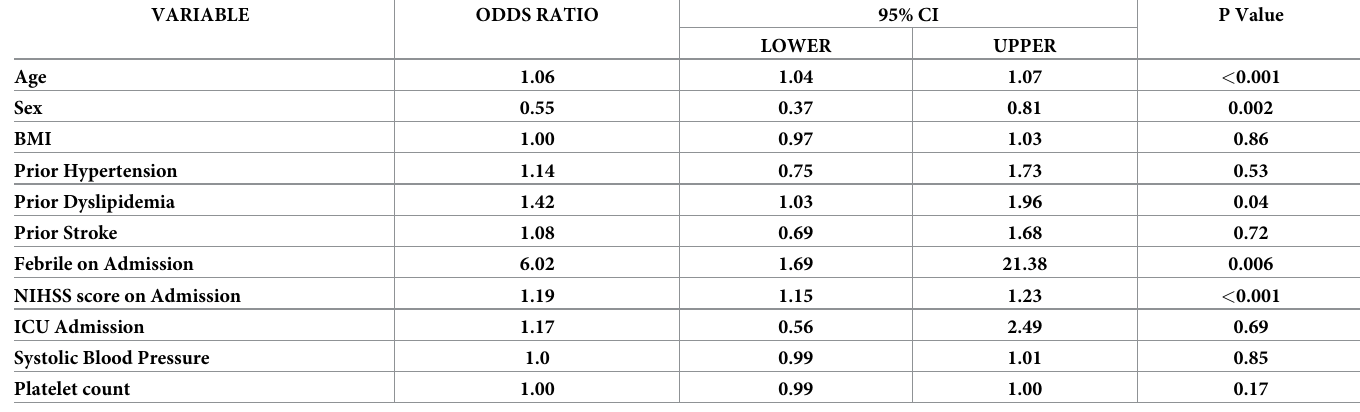
Table 2. Multivariate analysis of the variables associated with 90-day poor outcome in all three groups. VARIABLE ODDS RATIO 95% CI P Value